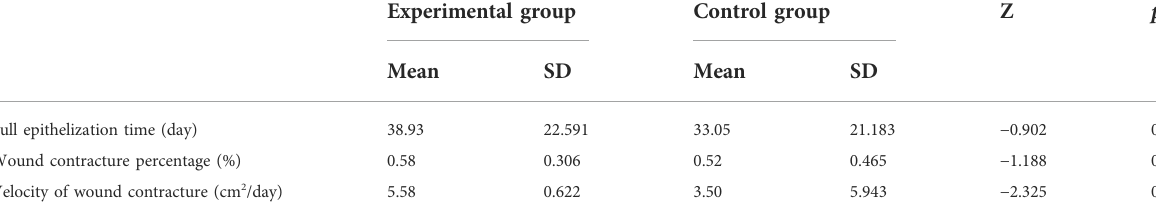
TABLE 3 Statistical analysis of effects on wound contracture status between two groups.